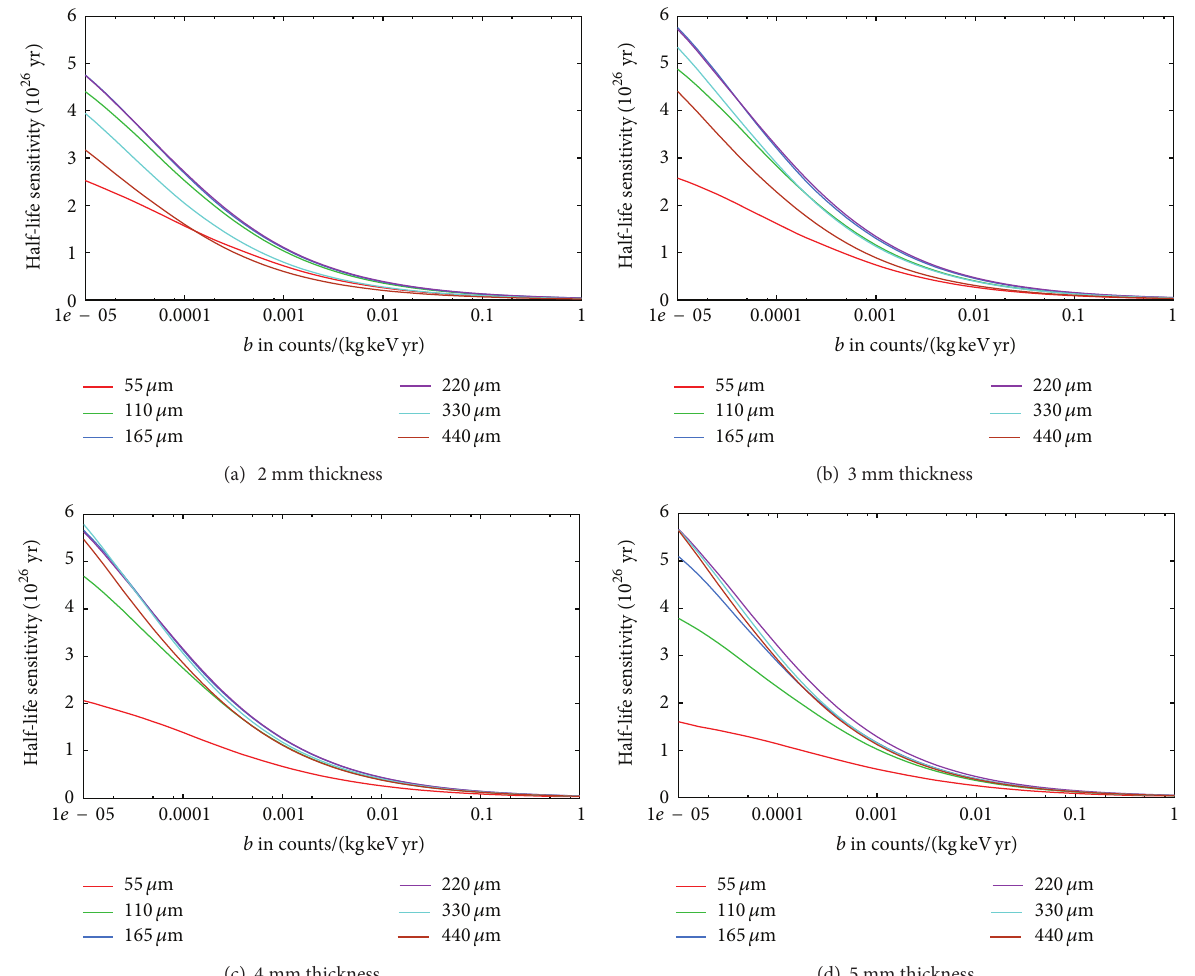
Figure 14: Simulated half-life sensitivity according to the unified approach [41] for 90% confidence level after 5 years of measuring time with 420 kg CdTe employing background identification for different combinations of sensor thickness and pixel size as functions of the specific single-electron background rate 𝑏